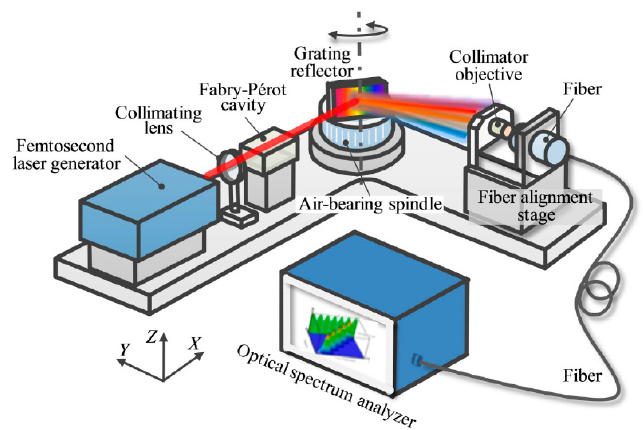
Figure 7. Femtosecond laser autocollimator based on the principle of the optical frequency-domain angle measurement [56].